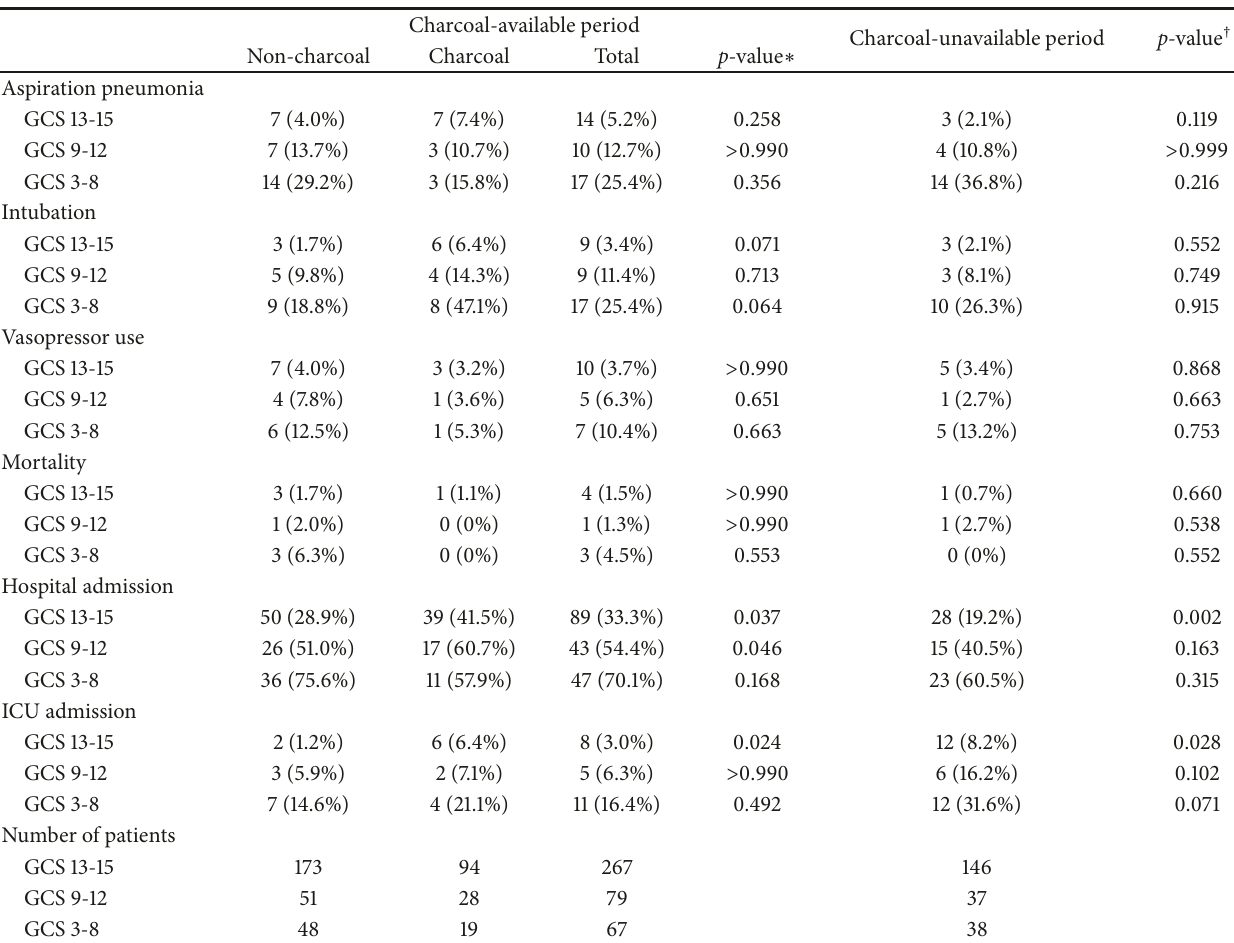
Table 4: GCS and clinical outcomes compared between charcoal-available and charcoal-unavailable periods. Charcoal-available period Charcoal-unavailable